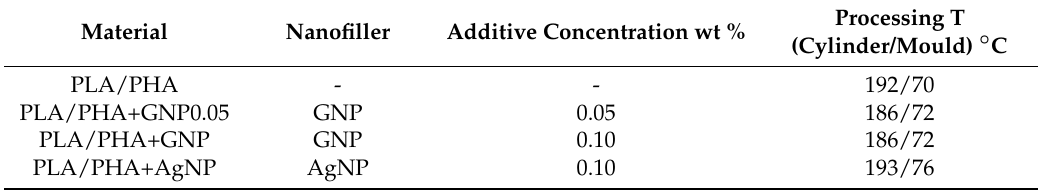
Table 1. Prepared Polylactic acid (PLA)/Polyhydroxyalkanoate (PHA) nanocomposites and their main synthesis